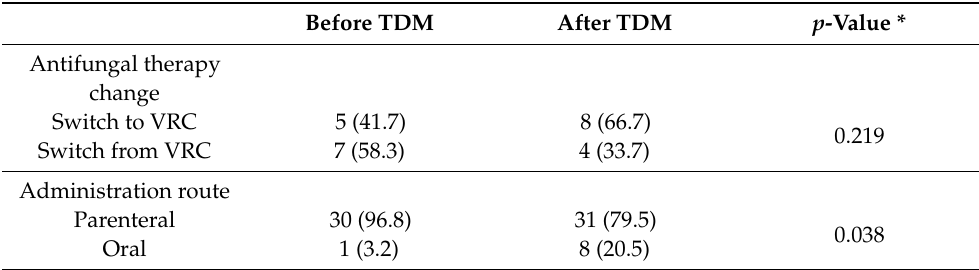
Table 1. Comparison of the periods before and after the TDM (n = 70), n (%). Before TDM After TDM p -Value *